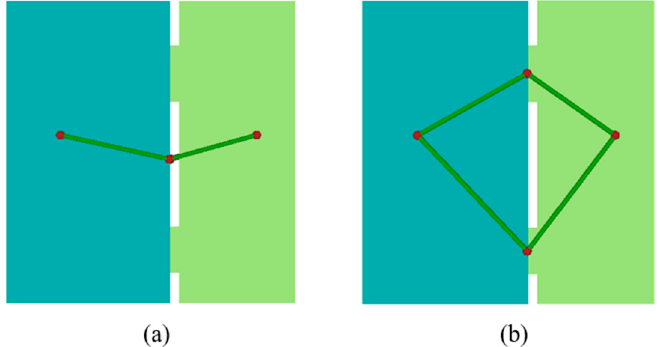
Figure 5. Basic NRSE derivation method ( a ) and the modified method for spaces with multiple connections ( b ).